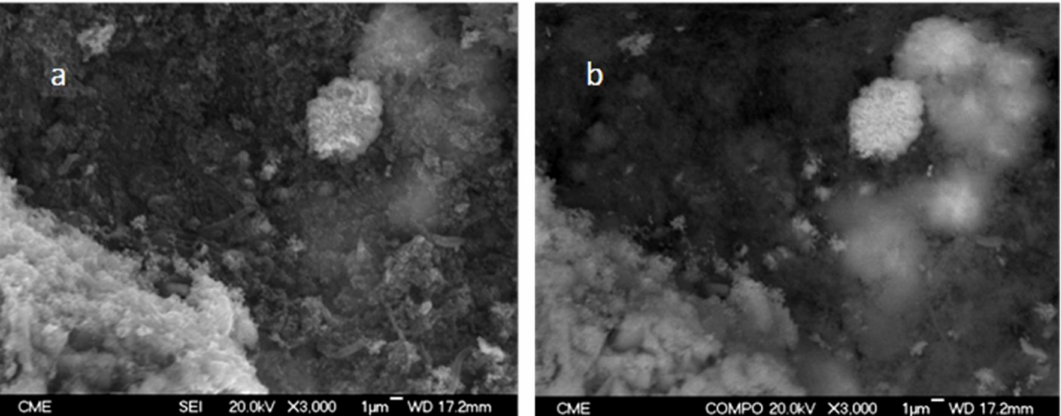
Figure 5. FE-SEM images of the residue of silver jarosite after incubation with microbes: ( a ) Secondary electrons, and ( b ) backscattered